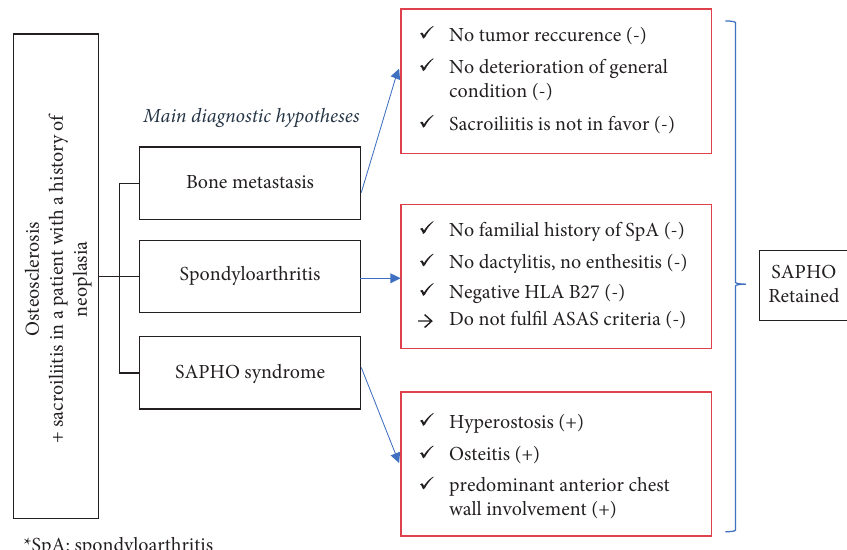
Figure 7: Summary diagram of case 3 diagnosis. SpA: